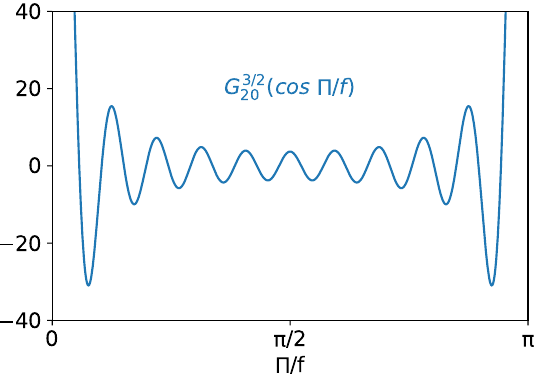
Figure 1 . For Π /f away from multiples of π and n large, the Gegenbauer polynomials G ( N − 1) / 2 n (cos Π /f ) approximately oscillate as cos n Π /f . For even n , their deepest minimum is the closest to kπ with k ∈ Z . For odd n , they take negative values at (2 k + 1) π where the deepest minimum is then also